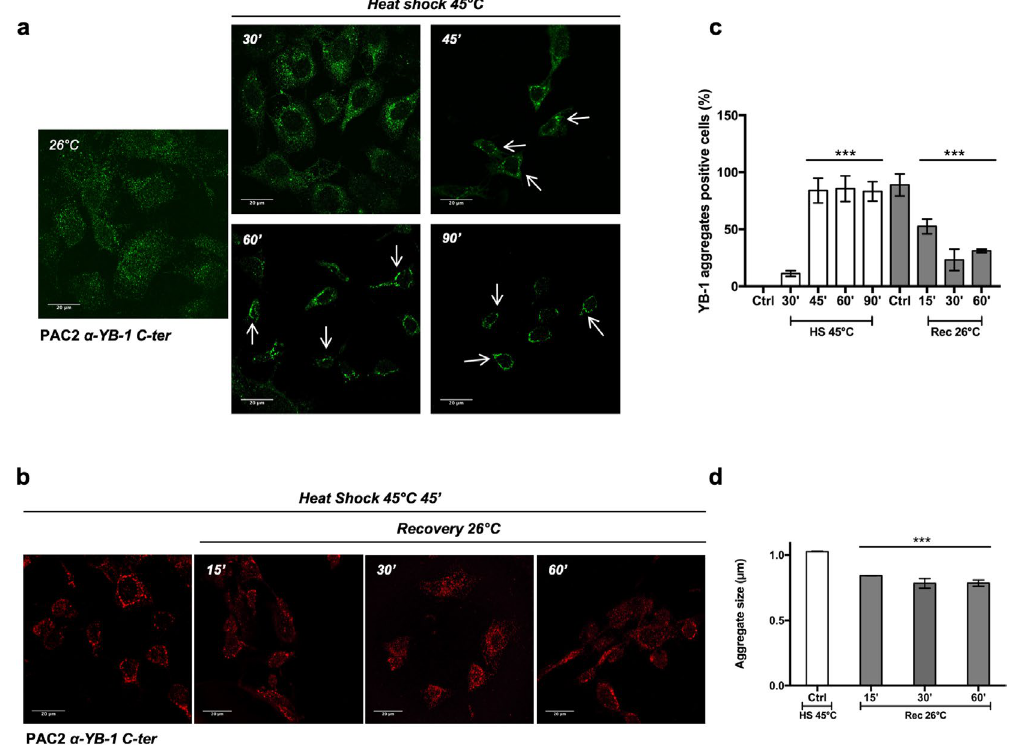
Figure 4. Kinetics of YB-1 aggregate formation. ( a ) confocal immunofluorescence of YB-1 (Green) in PAC2 cells at 26 °C (control) or after heat shock at 45 °C for the indicated times; ( b ) confocal immunofluorescence for YB-1(red) in PAC2 cells incubated at 45 °C for 45 ′ and then replaced at 26 °C for recovery from the heat shock at the indicated times; ( c ) percentage of cells forming YB-1 positive aggregates (plotted on the y-axes) incubated at 45 °C for the indicated times (white bars) and then allowed to recover for 15, 30 and 60 minutes at 26 °C (grey bars). Statistical analysis was performed using 1-way ANOVA and Dunnett’s multiple comparisons. Levels of significance are indicated ( *** p < 0.001) (see also Table S1); ( d) quantification of YB-1 positive aggregate dimensions in PAC2 cells incubated at 45 °C for 45 minutes (white bar) and then allowed to recover at 26 °C for the indicated times (grey bars). Statistical analysis was performed using 1-way ANOVA and Dunnett’s multiple comparisons. Levels of significance are indicated ( *** p < 0.001) (see also Table